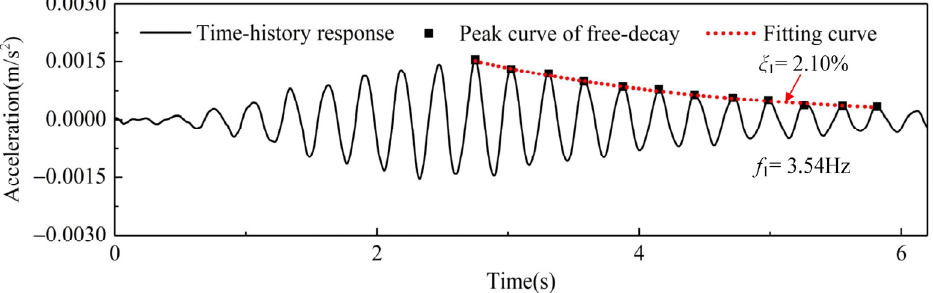
Figure 5. Free-decay acceleration response of the suspended floor at test point 1.